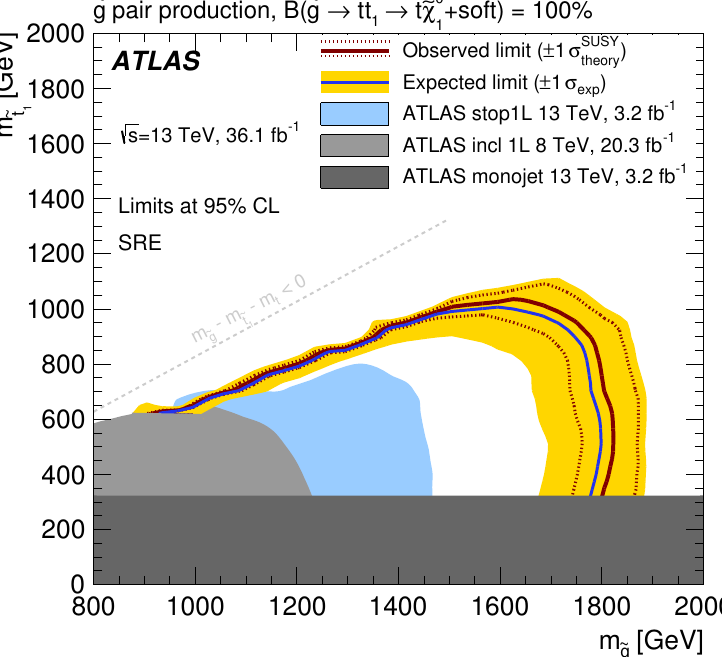
Figure 13. Observed (red solid line) and expected (blue solid line) exclusion contours at 95% CL as a function of ~ g and ~ t 1 masses in the scenario where both gluinos decay via ~ g ! t ~ t 1 ! t ~ (cid:31) 0 1 +soft and (cid:1) m ( ~ t 1 ; ~ (cid:31) 0 1 ) = 5 GeV. Uncertainty bands corresponding to the (cid:6) 1 (cid:27) variation of the expected limit (yellow band) and the sensitivity of the observed limit to (cid:6) 1 (cid:27) variations of the signal theoretical uncertainties (red dotted lines) are also indicated. Observed limits from previous searches with the p p ATLAS detector at s = 8 and s = 13 TeV are overlaid in grey and blue [27, 93, 94].